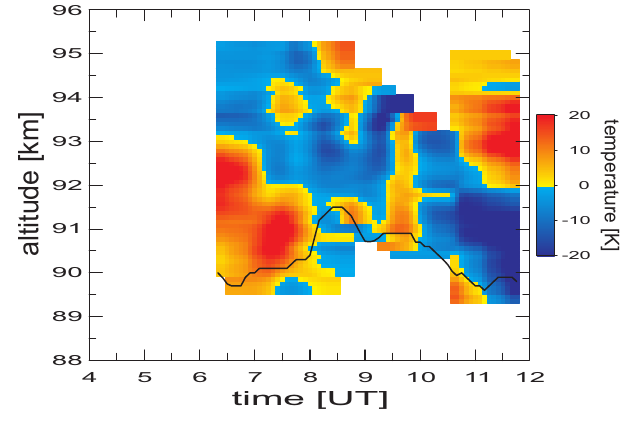
Fig. 5. Temperature deviations from the nightly mean temperature on 6 July 2003. The black line indicate the PMSE